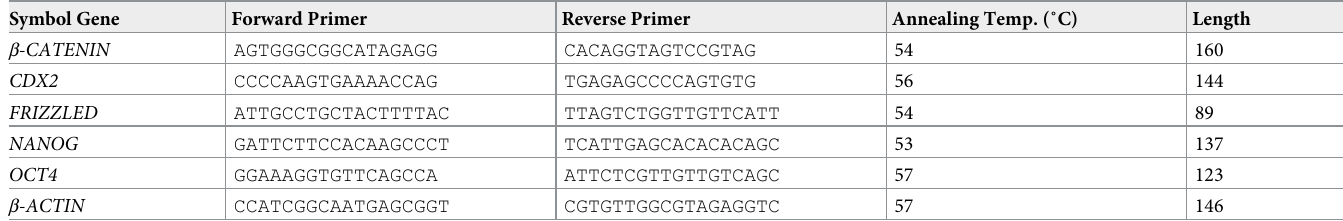
Table 1. List of primers used in this study for real-time